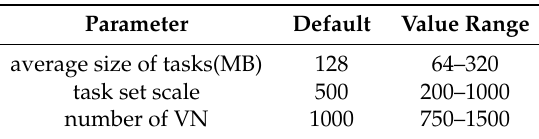
Table 2. Experimental default